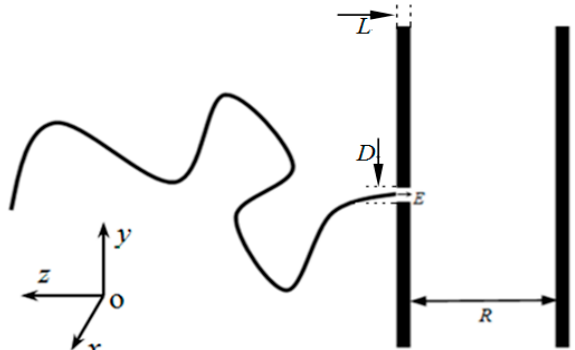
Figure 1. Schematic representation of polymer translocation into a confined space under the electric field strength E in the pore along − z -axis. The simulations are carried out in a planar confinement (3D), where two infinite parallel flat membranes are separated by a distance R . One membrane has a pore of length L = 2 and diameter D = 1.2.